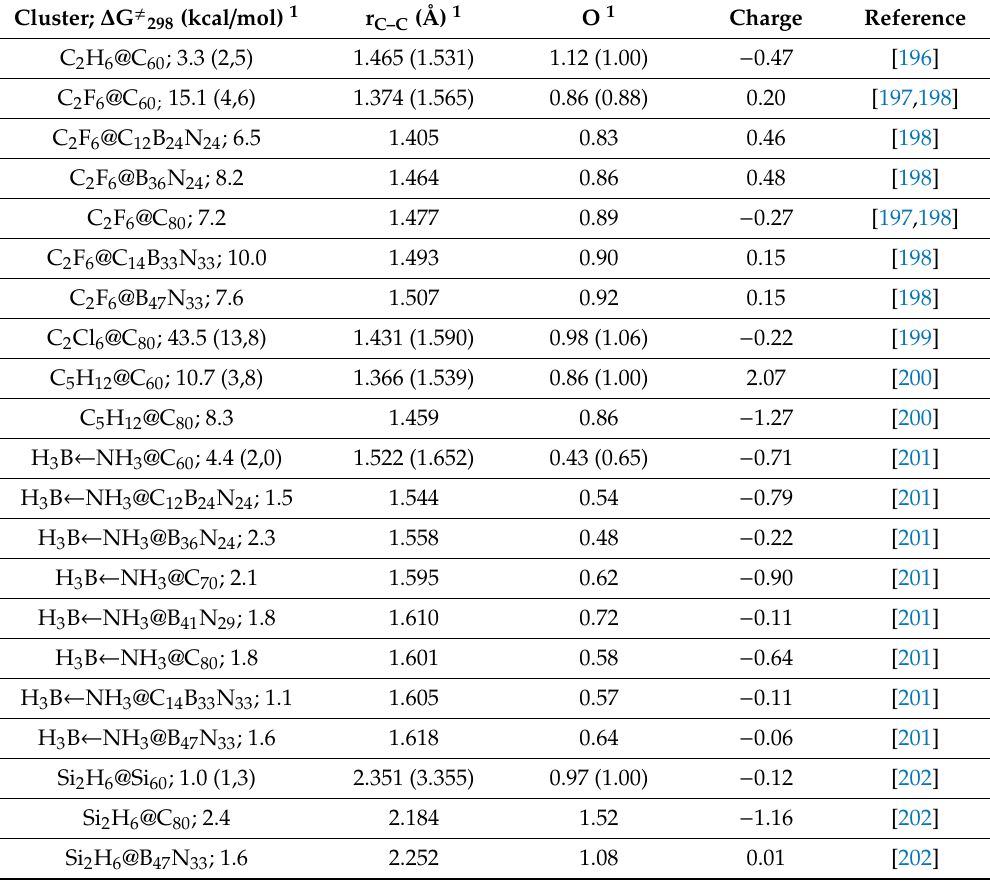
Table 3. Energetical and structural parameters of ethane and its analogs in fullerenes (PBE / 3 ζ ). Cluster; ∆ G (cid:44) 298 (kcal / mol) 1 Charge